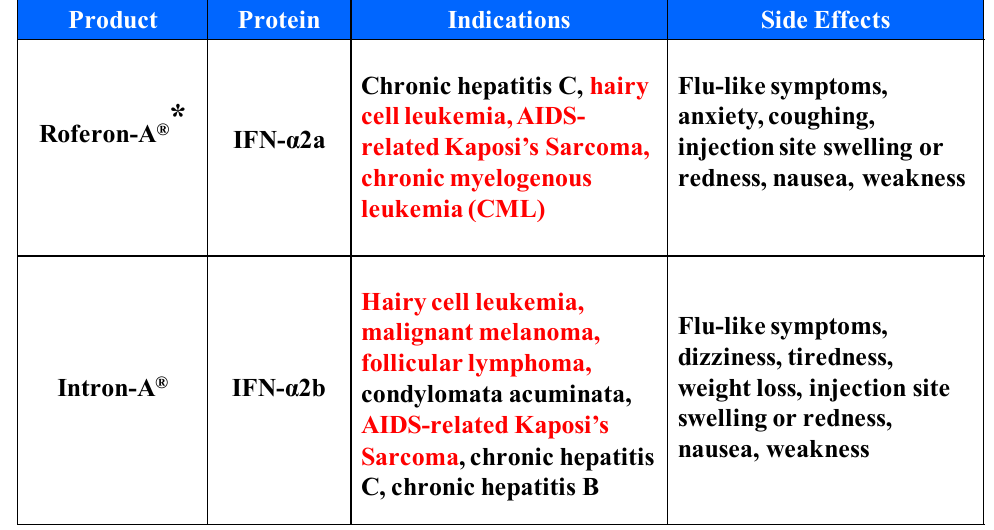
Table 1. Interferon- α s licensed by the U.S.F.D.A. which have anti-tumor applications (highlighted in red). *The market and sale of Roferon-A in the United States was discontinued in September 2007. This action was NOT due to the safety or efficacy of the